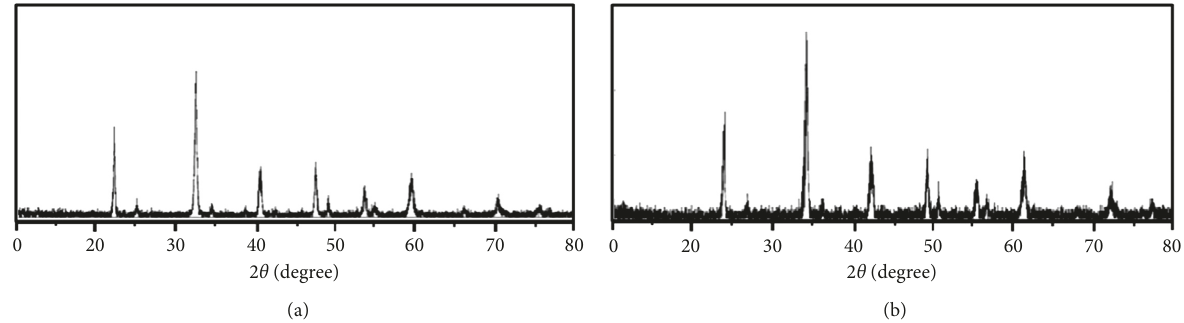
Figure 3: X-ray diffraction patterns of GdAlO Gd(NO 3 ) 3 · 6H 2 O in a sol-gel process at 1000 °